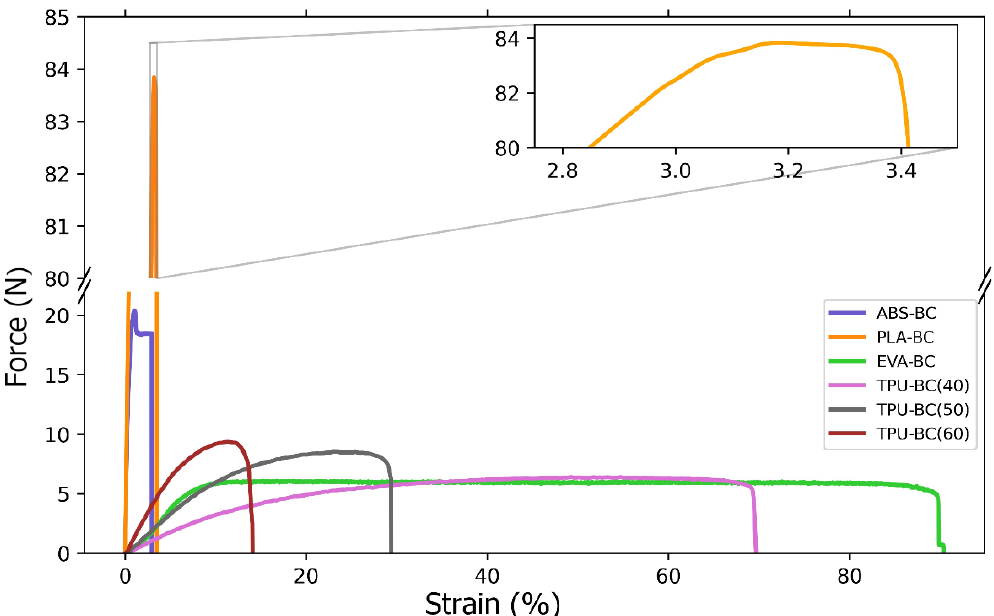
Figure 2. Stress and strain curves of composite fibres containing various polymers and biochar (BC) as a functional phase. Composites with ABS, PLA, and EVA contained 50% by weight of biochar, while for the TPU-biochar composite, the results for the three percentages of functional phase content are shown: 40%, 50%, and 60%.